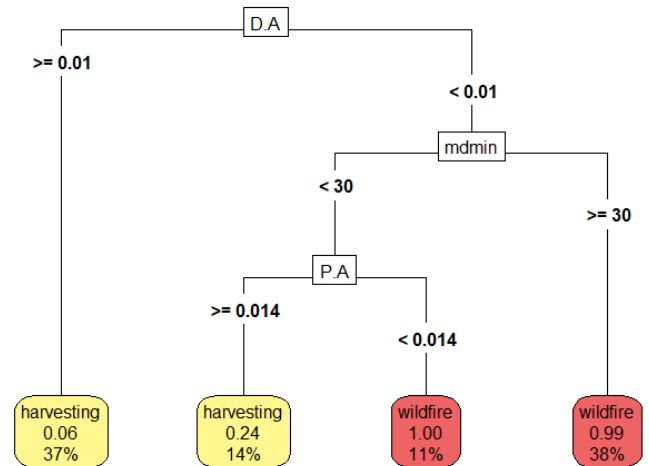
Figure 9. Decision tree that allows for the differentiation between harvesting and wildfires using the shape-related metrics calculated. D.A: the maximum diameter of the polygon formed by the cluster, calculated as the maximum distance between the vertices of two parts of the polygon, divided by the area of the polygon. mdmin: the average of the minimum distance from each disturbance pixel to its nearest disturbance pixel in the disturbance. P.A: the perimeter of the polygon formed by the disturbance divided by the area of the polygon.